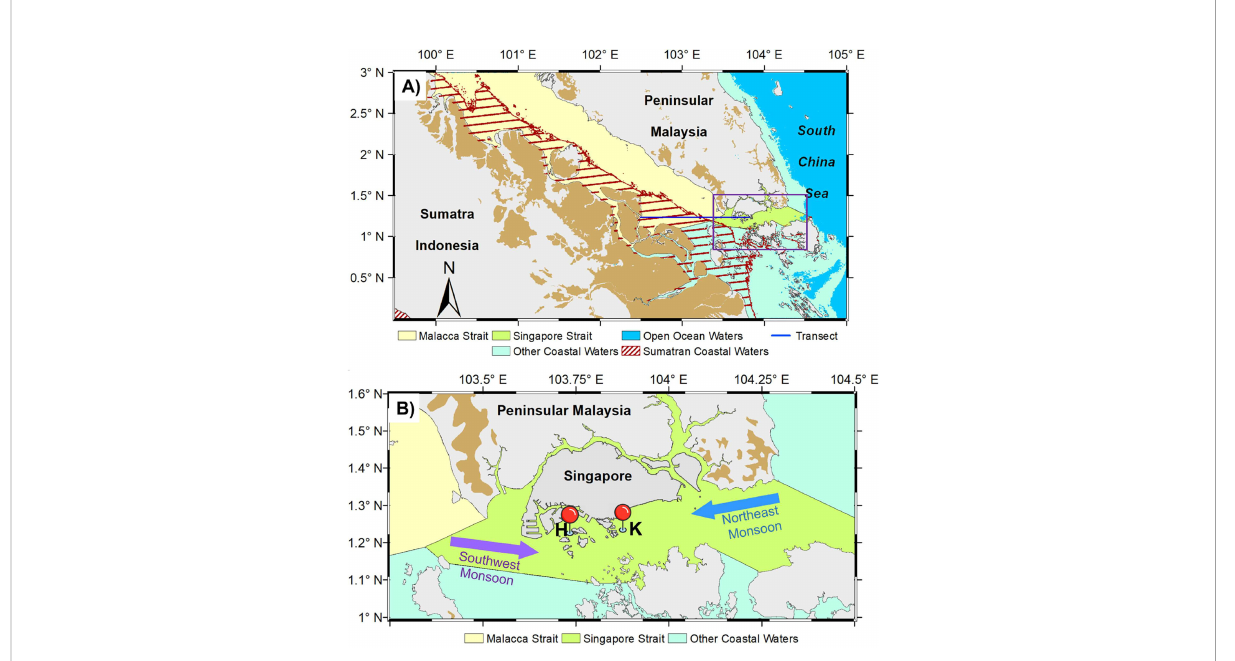
FIGURE 1 (A) Map of the study region showing the location of peatlands (brown in shading) and the delineation of water bodies across the Sunda shelf of Southeast Asia. The blue color line shows the transect from Sumatran coastal waters to Singapore Strait (latitude=1.24°CN. The purple box corresponds to the area shown in (B) . (B) The two main sampling sites in the Singapore strait waters are shown by red push pin indicators: the eastern site, Kusu (K) Kusu and western site Pulau Hantu (H). Purple and blue arrows show the mean current direction during each monsoon